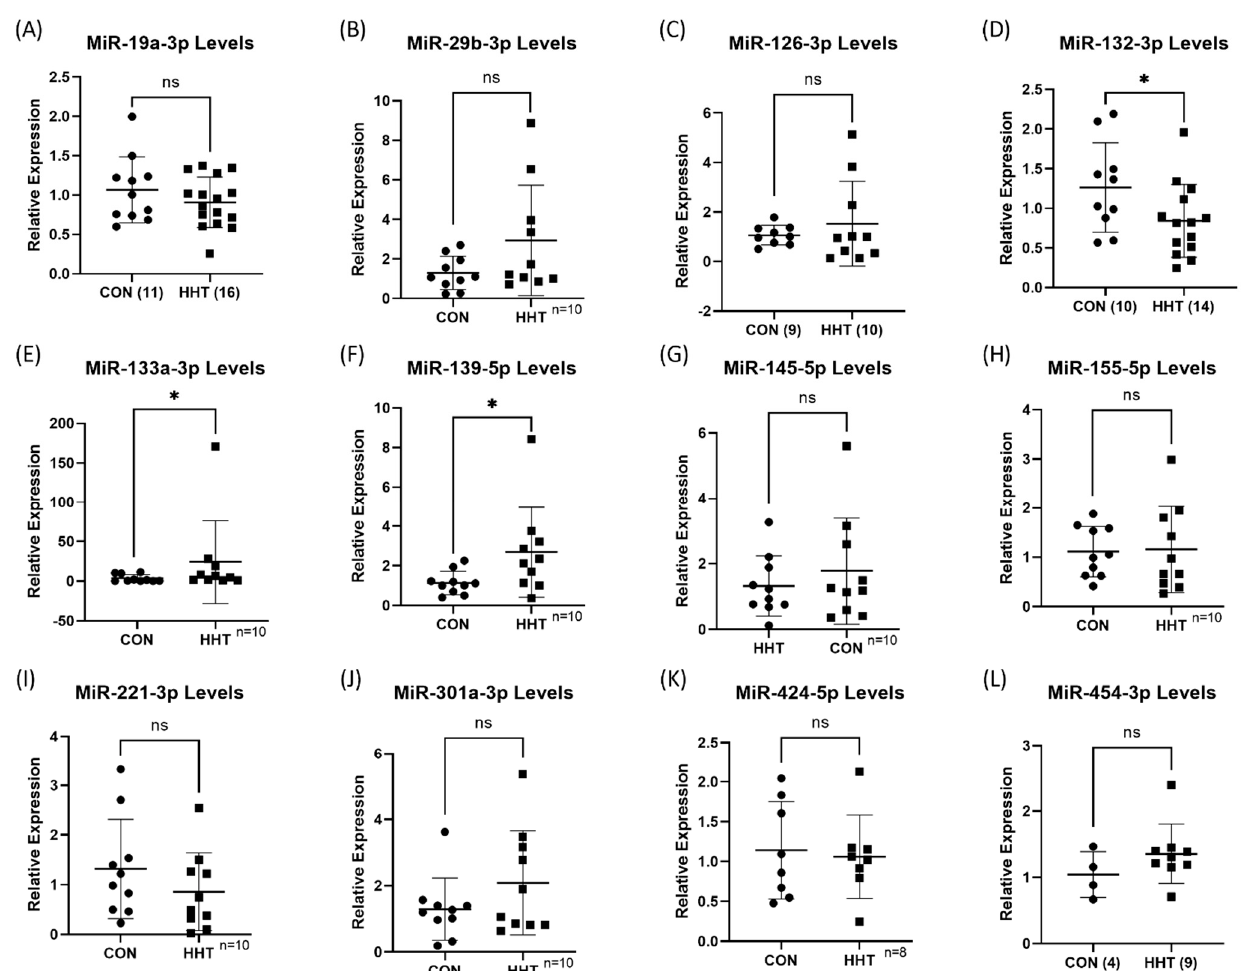
Figure 5. ( A – L ) RT-qPCR validation of 12 miRNAs. Three miRNAs as indicated in the graphs were found to be significantly different in HHT and control MACs, while nine as indicated were not. * p < 0.05, and ns indicates not statistically significant.